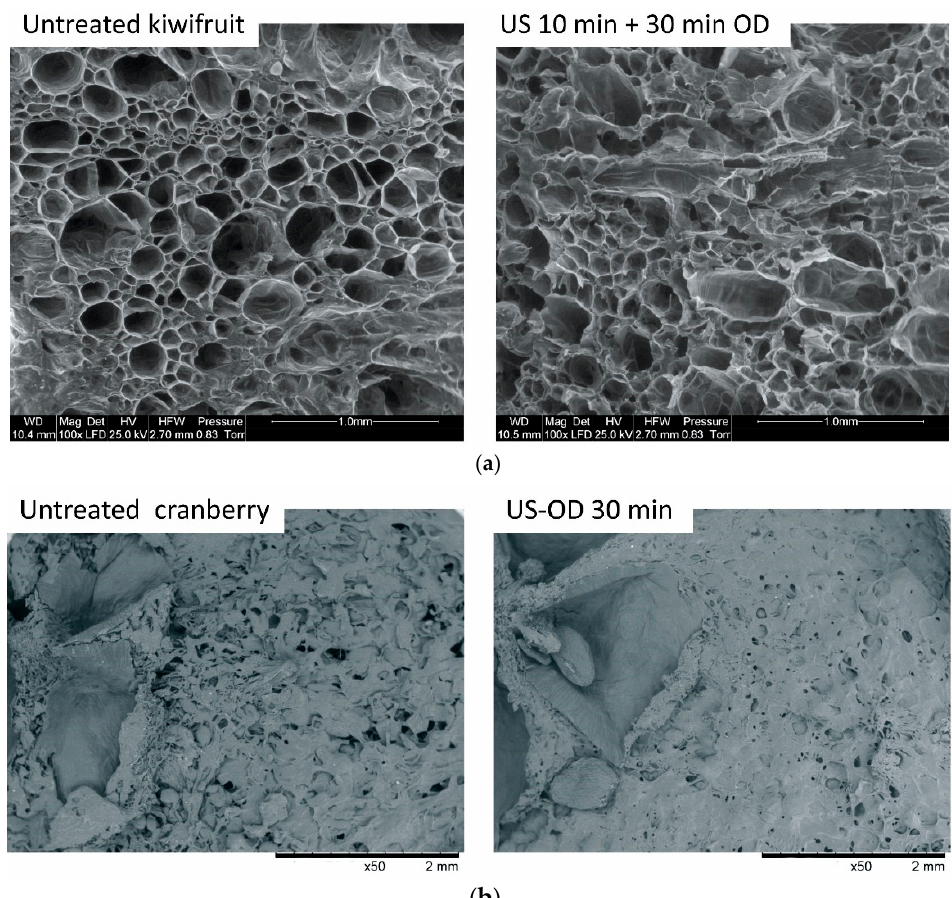
Figure 3. Structural changes of: ( a ) kiwifruits subjected to ultrasound treatment (10 min) and osmotic dehydration (30 min); and ( b ) cranberries treated with ultrasound-assisted osmotic dehydration (30 min). Own unpublished data.